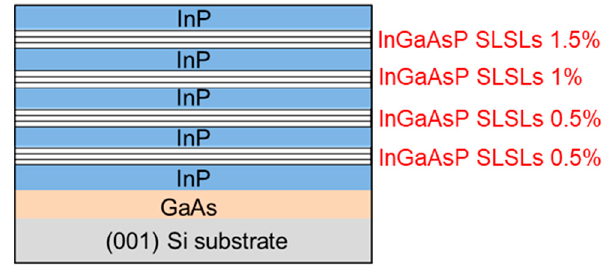
Figure 2 . Schematic of the epitaxial stack. Figure 2. Schematic of the epitaxial